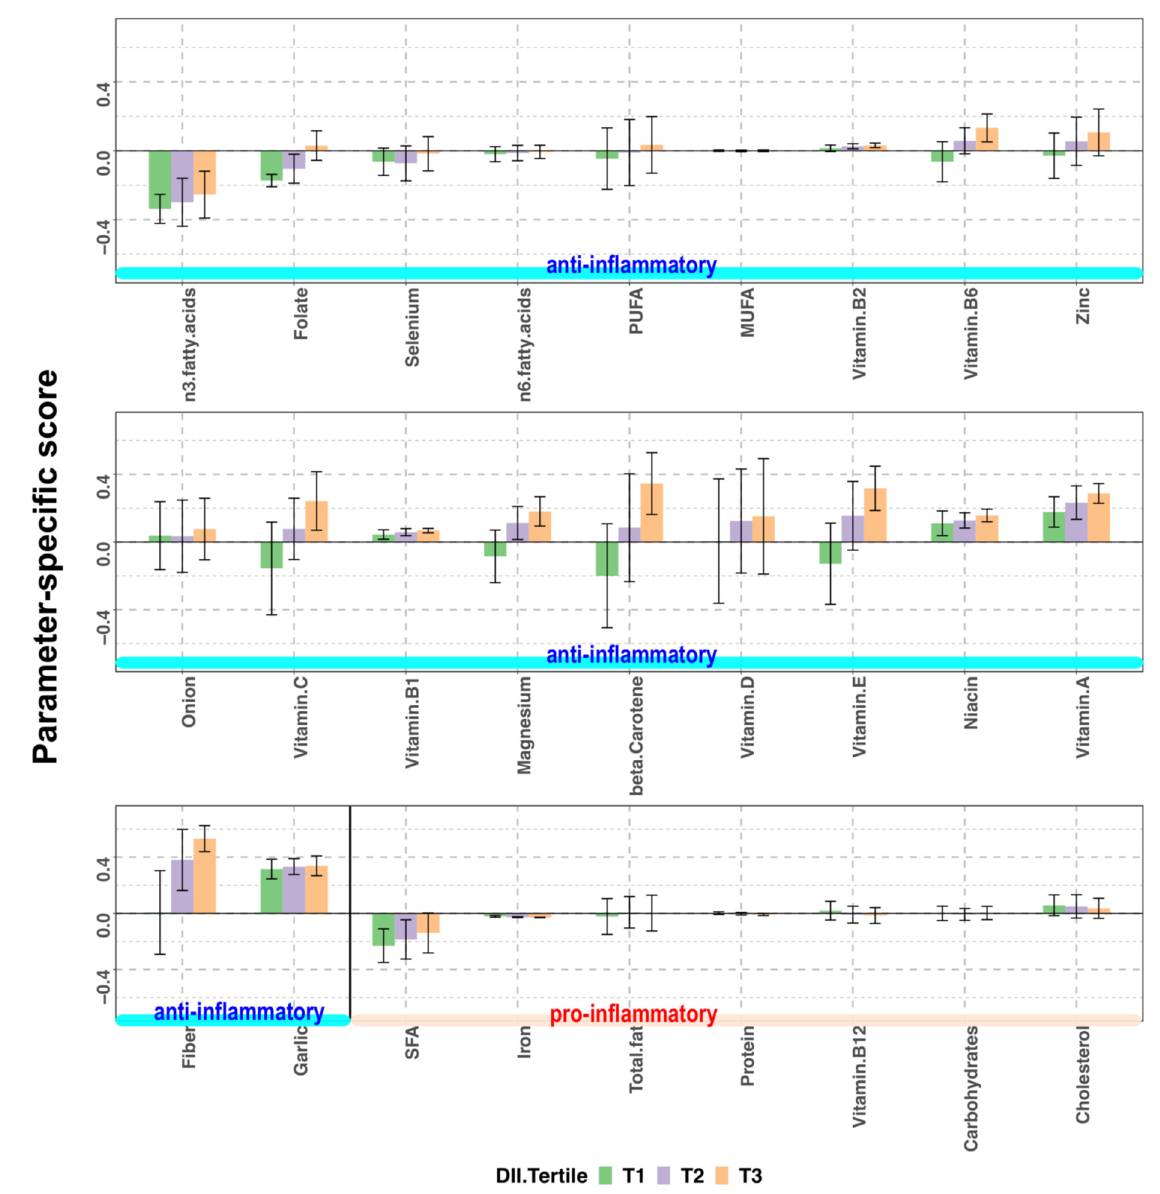
Figure 4. Parameter-specific scores according to the tertiles (T) of energy-adjusted dietary inflammatory index (E-DII) score in pregnant women of a birth cohort, BC-GENIST, in Japan. Bars represent the mean and error bars represent standard deviation (SD). The anti-inflammatory and pro-inflammatory parameters constituting the E-DII score are shown from left to right, from the lowest to the highest mean score of the entire cohort. Since the overall inflammatory effect scores of anti-inflammatory parameters are negative, lower intake of anti-inflammatory nutrients compared to the global mean result in a positive parameter-specific score. In contrast, as the overall inflammatory effect scores of pro-inflammatory parameters are positive, higher intake of pro-inflammatory nutrients result in a positive parameter-specific score. Higher E-DII scores indicate higher inflammatory potential. SFA, saturated fatty acids; MUFA, monounsaturated fatty acids; PUFA, polyunsaturated fatty acids; n = 36 (T1), 36 (T2), and 36 (T3).